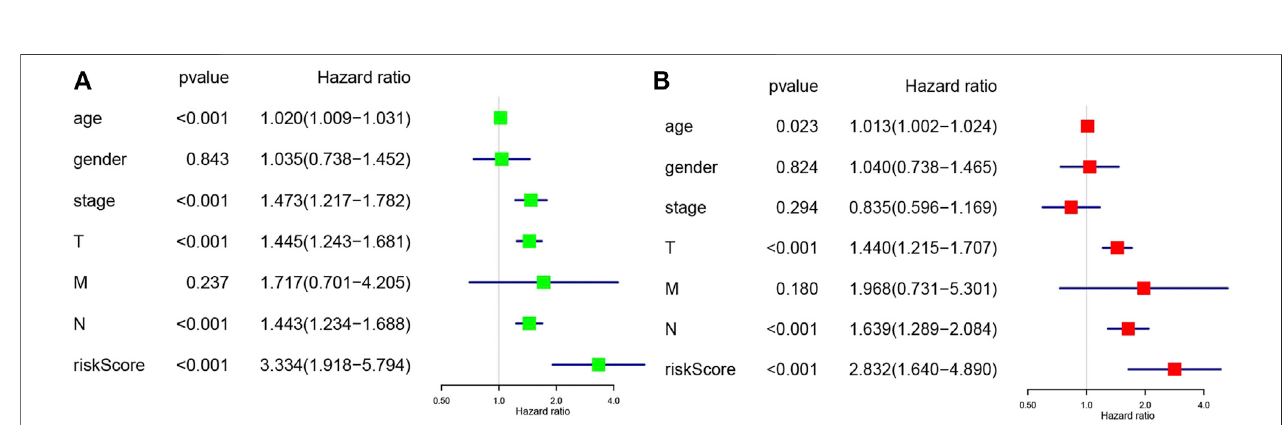
FIGURE 6 | (A) Univariate analysis of the hazard ratios for risk score as independent prognostic elements to aniticipate the overall survival. (B) Multivariate analysis of the hazard ratios for risk score as independent prognostic elements to predict the overall survival.